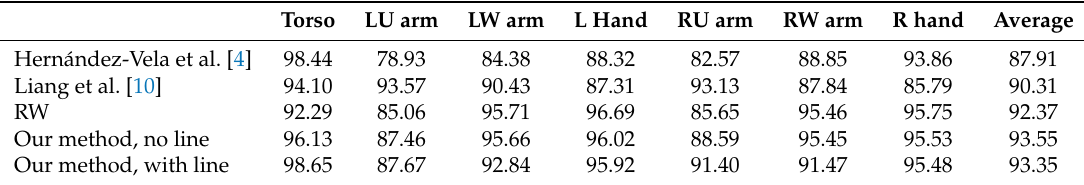
Table 2. Dataset 1 [4]: mean per-class accuracy in % over all frames.